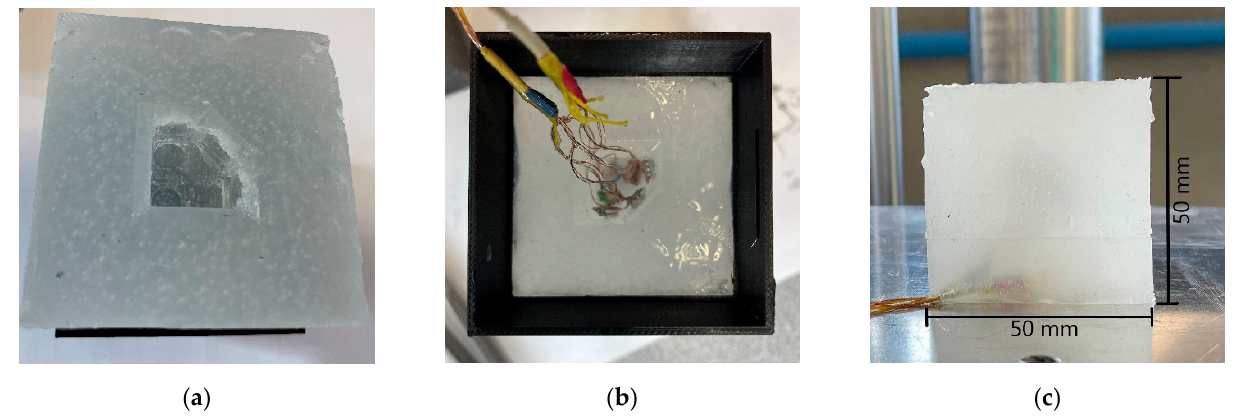
Figure 4. Casting procedure: ( a ) Result of the first cast, the upper part of the specimen is realized with a cavity to insert the sensors. ( b ) Sensor positioned inside the cavity; uncured silicone rubber is added to make the sensor adhering to the cured material. The upper cast is positioned for the final step. ( c ) Result after the casting, sensors are embedded, and their cables exit from a vertex of the specimen.